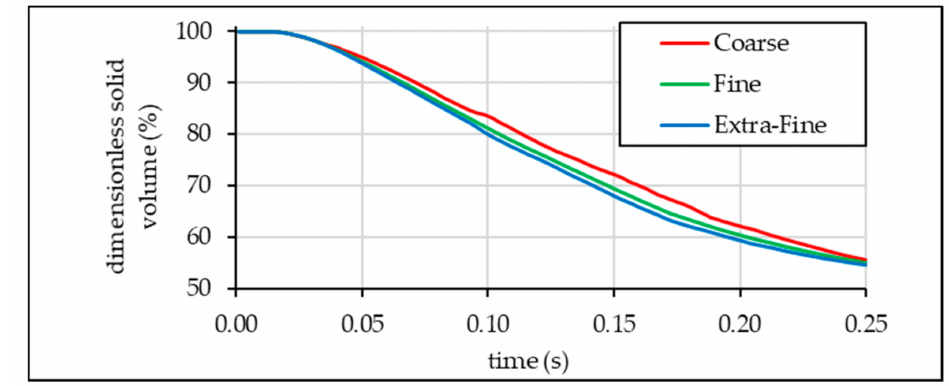
Figure 16. Dimensionless solid volume evolution through time for different meshes (Cu = 10 6